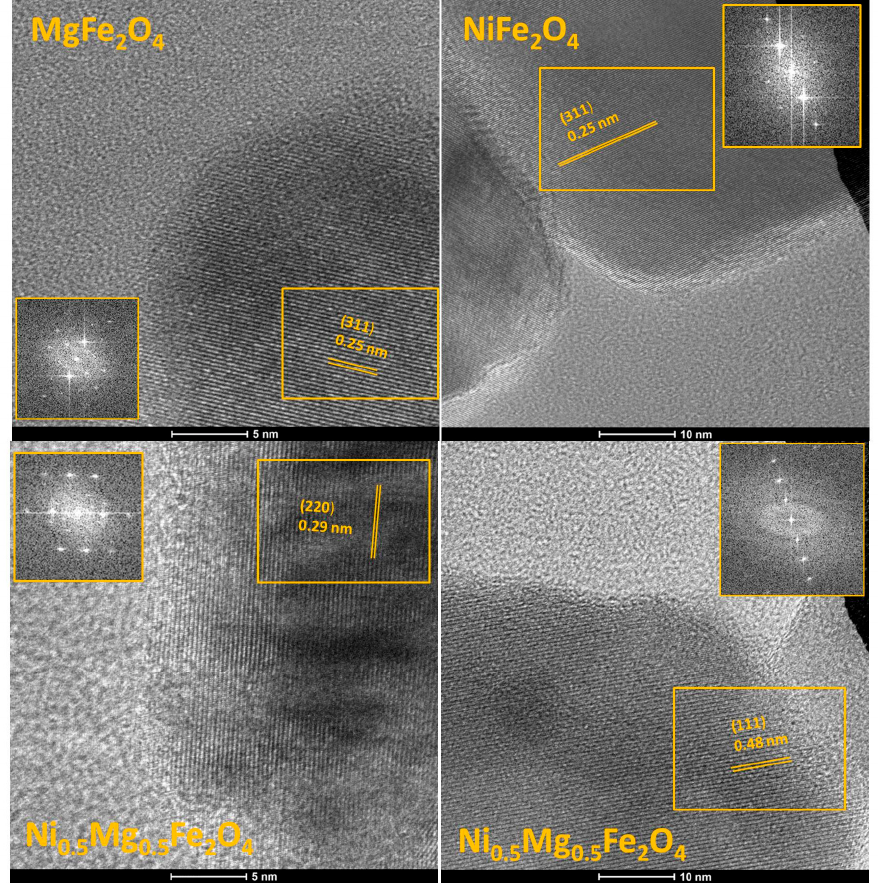
Figure 5. HRTEM micrographs of selected MgFe 2 O 4 , Ni 0.5 Mg 0.5 Fe 2 O 4 and NiFe 2 O 4 particles showing crystal lattice planes with d-spacing of 0.25, 0.29 and 0.48 nm, confirming the presence of (311), (220) and (111) crystal faces of the cubic spinel lattice phase.